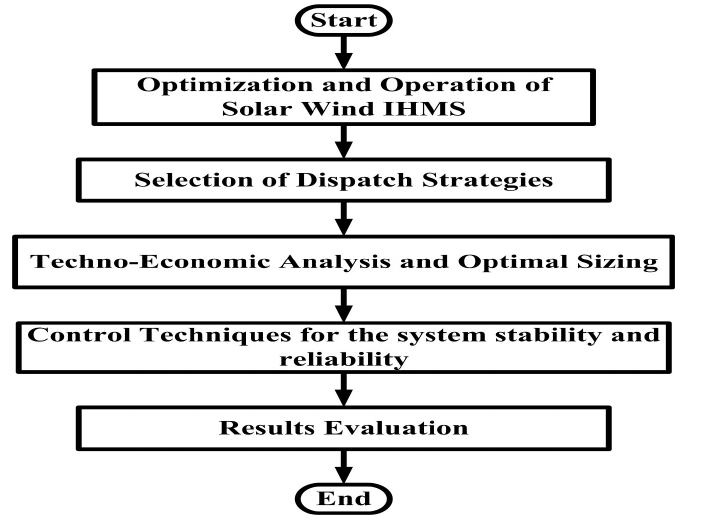
Figure 5. A flow diagram of the correlation between the optimization technique and control strategy for the solar-wind